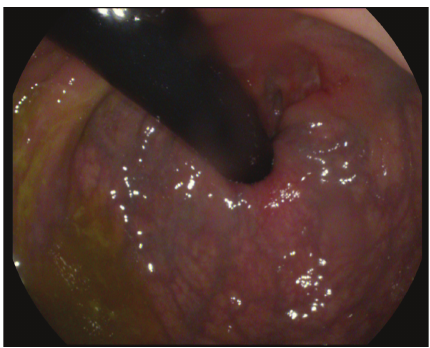
Figure 1: An endoscopic retroversion image of rectal ampulla showing an ulcerated lesion at the posterior commissure.